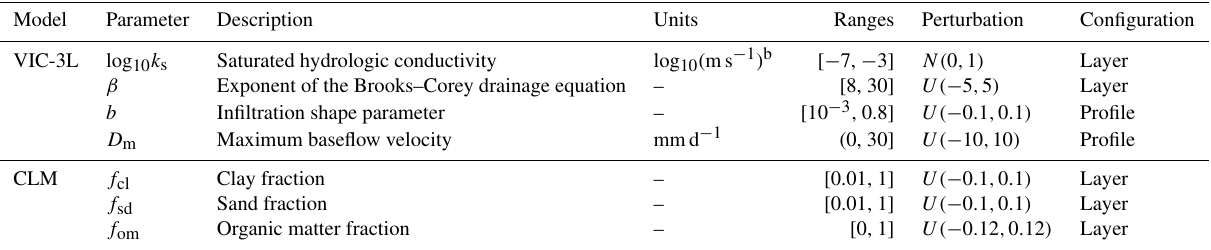
Table 1. Description of the soil parameters of VIC-3L and CLM that are subject to inference with the different data assimilation methods using the 5-month soil moisture calibration data period of the Rollesbroich site. We list the symbol, unit, feasible range, perturbation, and domain of application of each parameter of VIC-3L and CLM. The column with the header “Perturbation” lists the statistical distributions that are used to create the initial parameter ensemble for each data assimilation algorithm. The notation N(a,b) signifies the univariate normal distribution with mean a and standard deviation b , whereas U(a,b) denotes the univariate uniform distribution between a and b . These perturbation distributions are centered on the best-guess parameter values of VIC-3L and CLM (see Sect. 4.2) and define together the prior parameter distribution. This prior distribution honors textural measurements of each soil layer and its dispersion is in agreement with previously published